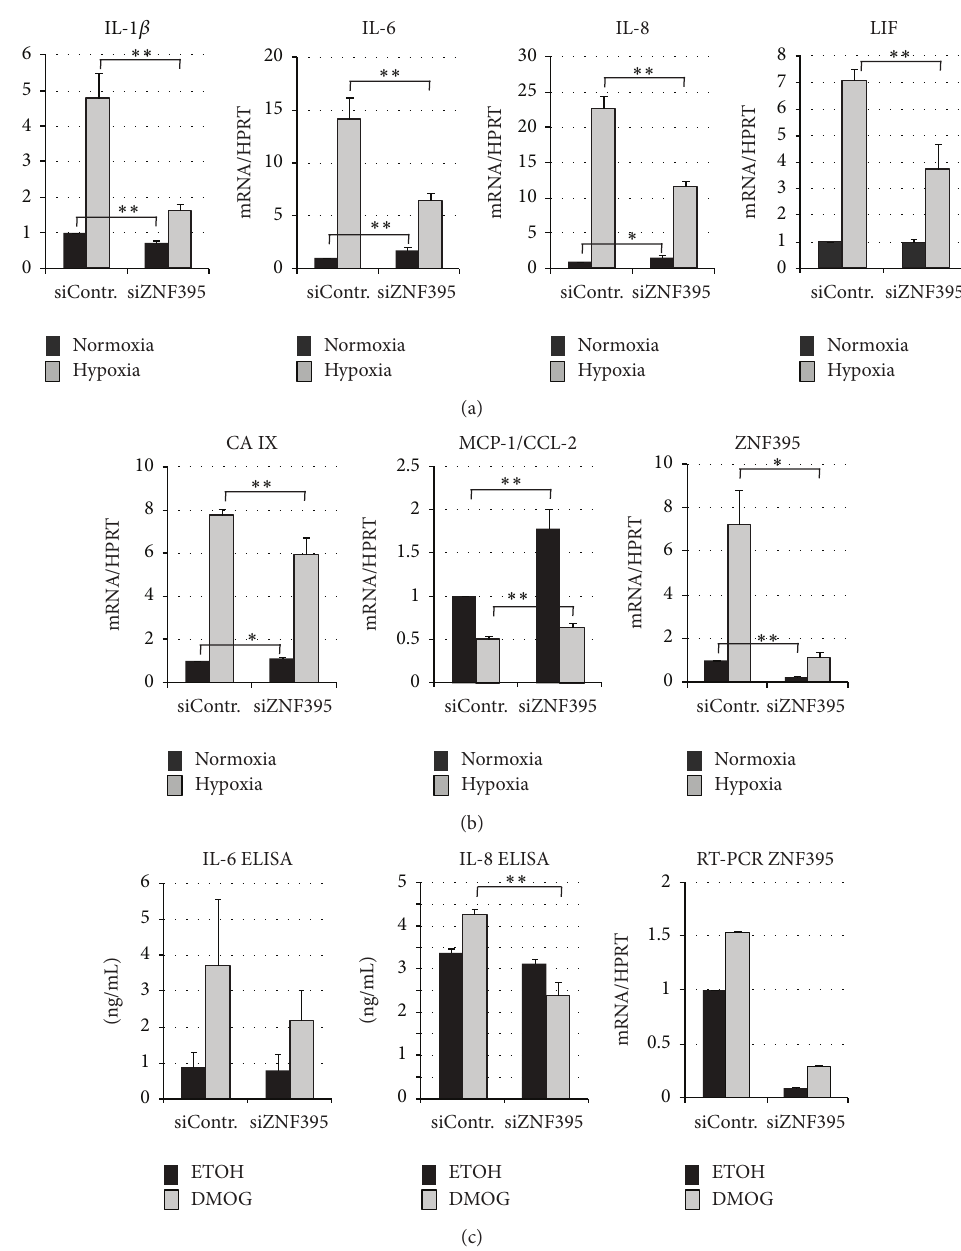
Figure 2: U87-MG cells were transfected with control siRNA or siRNA against ZNF395 and total RNA was isolated 48 hours after transfection (normoxia) or the cells were transferred 36 hours after transfection to 2% O 2 for additional 12 hours (hypoxia) before total RNA was isolated. cDNA was prepared and quantitative real time-PCRs were performed with primers specific for IL-6, IL-8, IL-1 𝛽 , and LIF (a) and for MCP- 1/CCL2, CA IX, and ZNF395 (b) RT-PCR of HPRT serving as internal control. The values obtained by dividing the Ct values for the